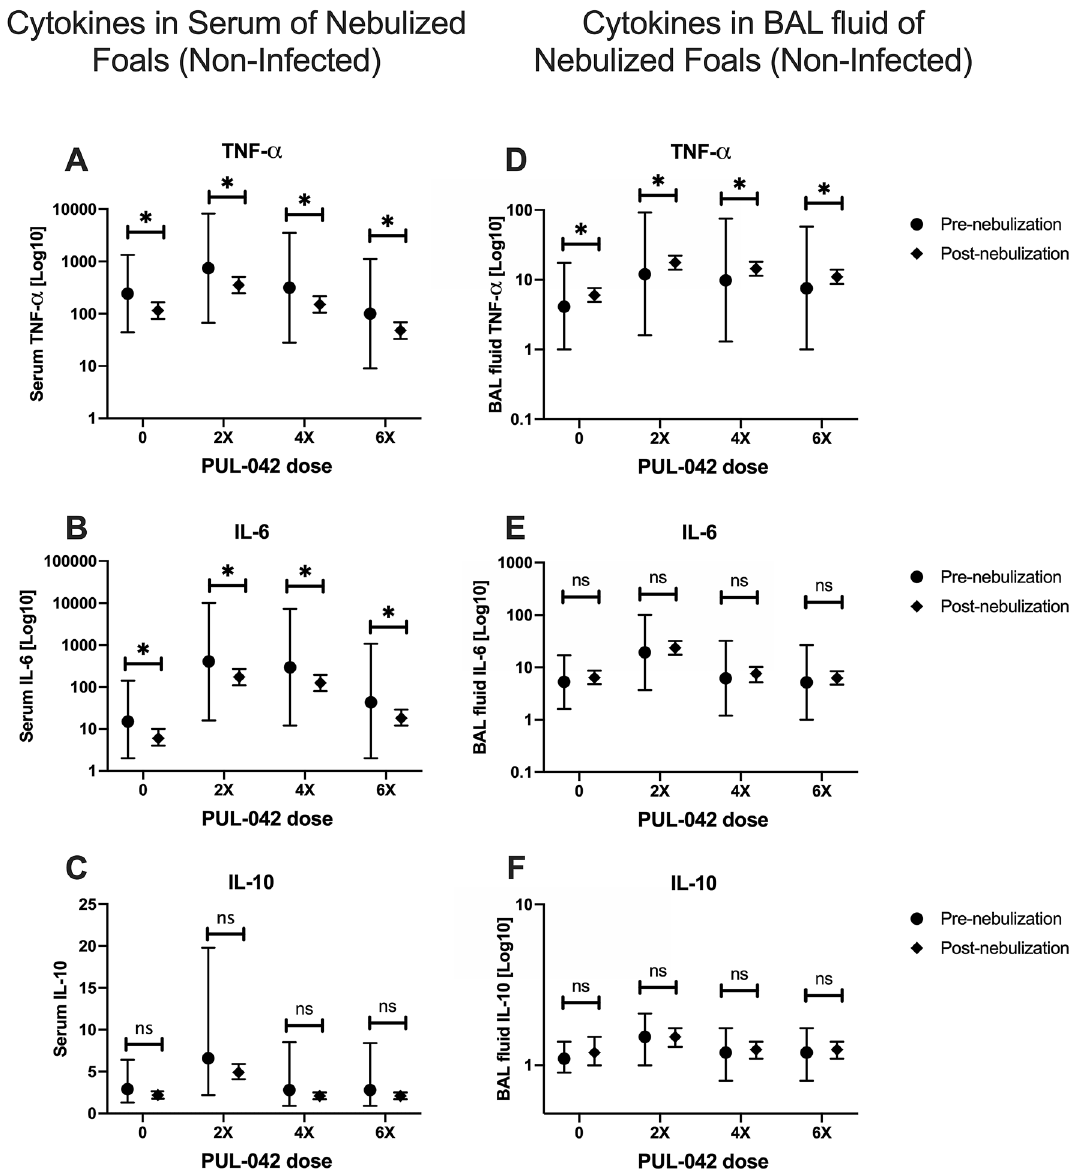
Figure 3. Concentration of pro- and anti-inflammatory cytokines in serum (left panel) or broncho-alveolar lavage (BAL; right panel) fluid of foals either before (Pre-nebulization) or after (Post-nebulization) serial nebulization with PUL-042 at various concentrations: 0 (n = 12), 2× (n = 12), 4× (n = 12), or 6× (n = 12). Cytokines were measured per ml of either serum or BAL fluid (TNF-α = pg/ml; IL-6 = pg/ml; IL-10 = ng/ ml). All foals were nebulized and no foals were infected in vivo with Rhodococcus equi . BALs were performed pre (day 2 after birth) and post (day 22, 1 day after the last nebulization). In serum, TNF- ⍺ ( A ) and IL-6 ( B ) significantly decreased with age, but only IL-6 had 1 group (PUL-042 2X) that was significantly different than PUL-042 0. Serum concentration of IL-10 ( C ) did not significantly differ among treatment groups or age. Tumor necrosis factor-alpha significantly increased in BAL fluid ( D ) for all groups, but effects were higher in BAL fluid of PUL-042 treated animals. The concentration of IL-6 ( E ) and IL-10 ( F ) in BAL fluid also did not significantly change with either age or treatment. Mean is represented by the symbol (circle for pre-nebulization; diamond for post-nebulization) and 95% confidence interval (as suggested by our findings) that nebulization of glycerol solution alone activates innate immune responses, albeit to a lesser extent than the PUL-042. It is possible that glycerol, at low concentrations such as used in this study (2.8%), induces a beneficial inflammatory response. We speculate, however, that the small sample size of the nebulized glycerol vehicle control group precluded us from detecting a significant difference between the PUL-042 and glycerol vehicle. Nevertheless, our results indicate that nebulization with PUL-042 significantly reduced the severity of disease in treated foals.